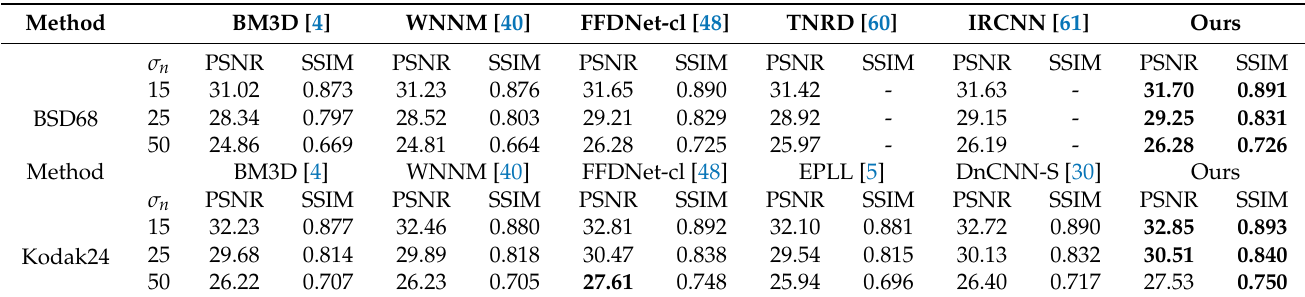
Table 4. The average PSNR values of test methods for denoising on the Bsd68 and Kodak24 datasets.